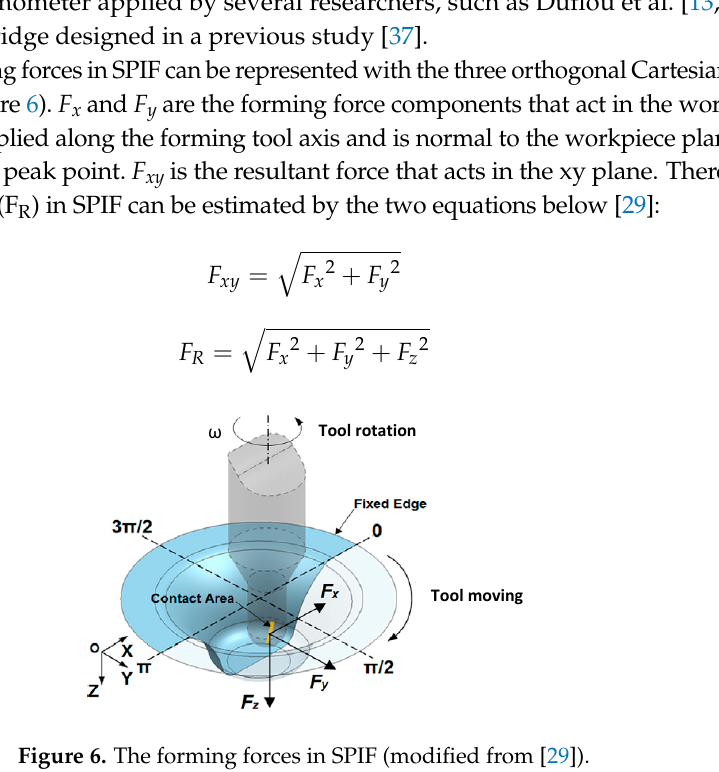
Figure 8. Setting the tool trajectory parameters using CATIA software. During the process, the continuous movement of the tool generates a local heating process and increases the rates of tool wear due to the friction at the tool-sheet contact zone. These two aspects affect both the geometric accuracy and surface finish, which simultaneously leads to an increase in forming forces. Different types of lubricants have been used for SPIF methods to minimize these harmful effects. In the current study, the lubricant SAE (BLAZE RACING SYNTHETIC BLEND 10W- 40) was applied to reduce the effects of the friction. The Taguchi method was used to design the experiments with a minimum number to save costs and time consumption during the experiments [40,41]. The design of experiment, which includes selecting the main process parameters and their levels, was in accordance with previous literature. From this literature, it was found that these parameters and their levels depend highly on the material properties. Additionally, the primary tests were conducted to ensure the correct choosing of these parameters and their levels to get satisfactory